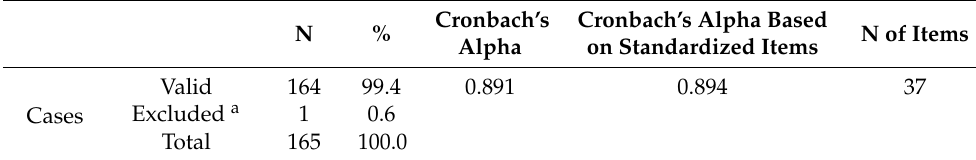
Table 6. Case Processing Summary and Reliability Statistics.